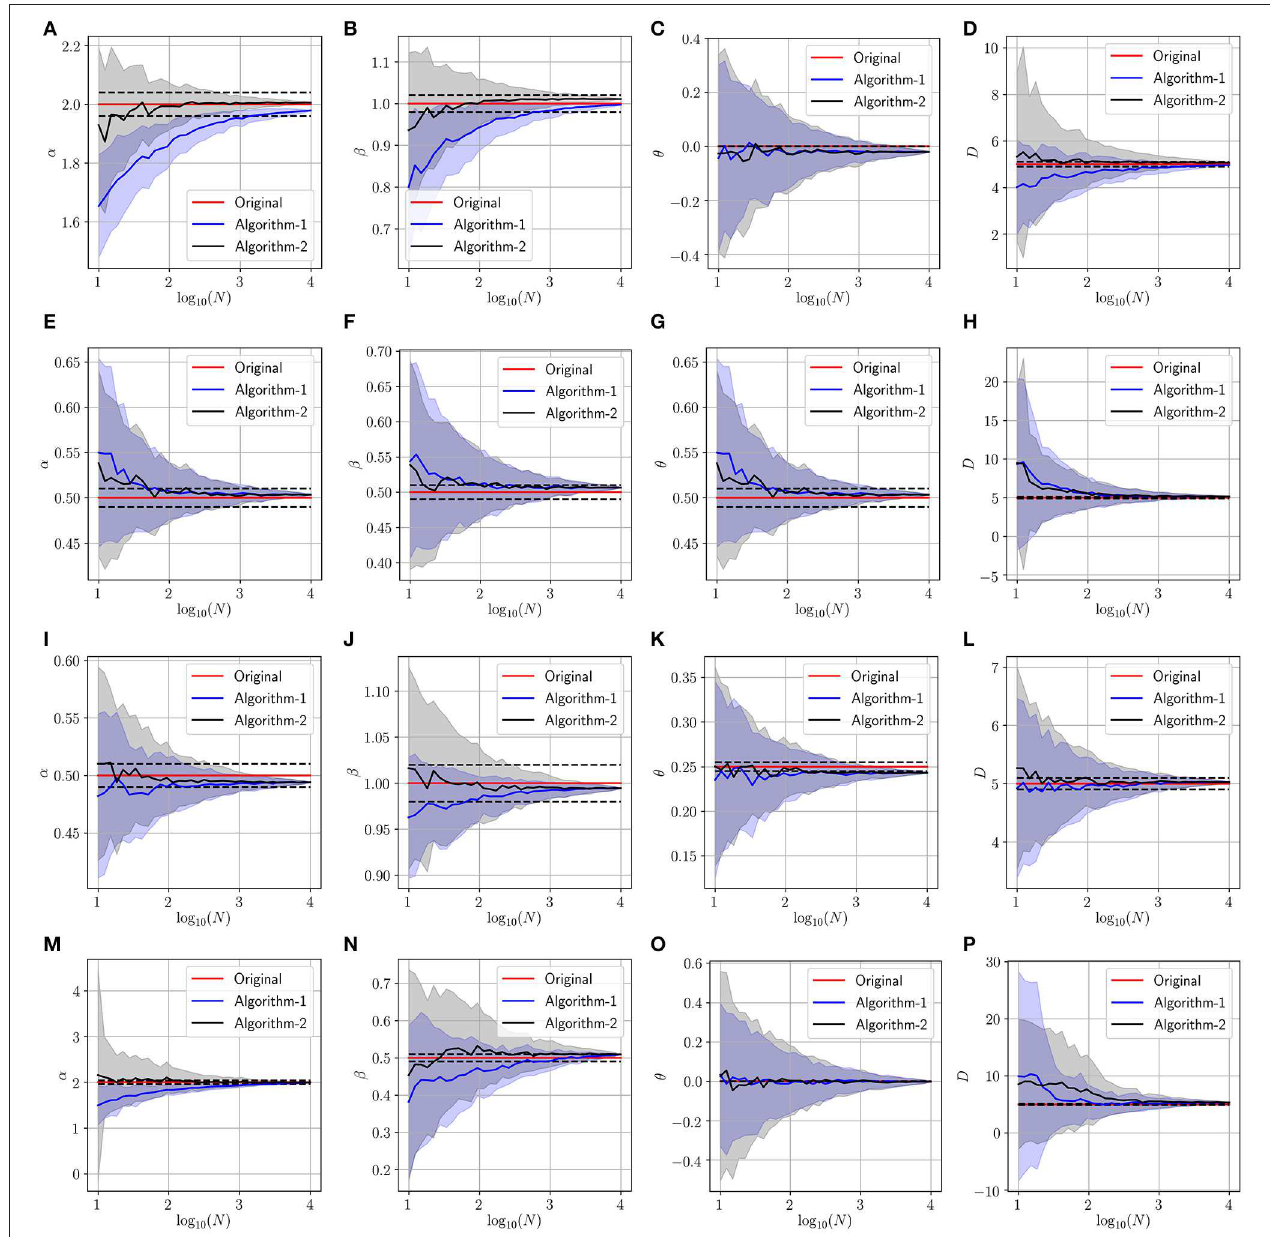
FIGURE 5 | Determining the parameters of the space-time fractional diffusion via the two proposed algorithms while varying the number of trajectories and the generalized diffusion coefficient D 5. The dotted line indicate 2 % error tube around the original parameter value in the red: (A–D) Normal diffusion equation = ( α 2, β 1, θ 0), (E–H) Neutral diffusion equation ( α 0.5, β 0.5, θ 0.5), (I–L) Space fractional diffusion equation ( α = = = = = = fractional diffusion equation ( α 2, β 0.5, θ = = =